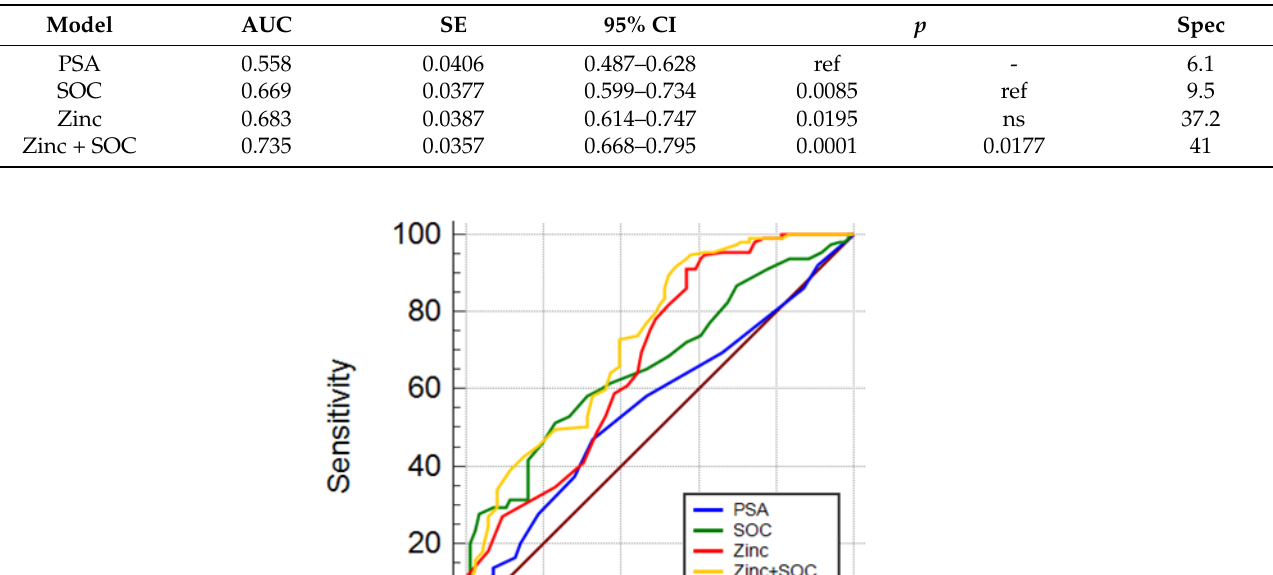
Table 6. Validation of diagnostic models.